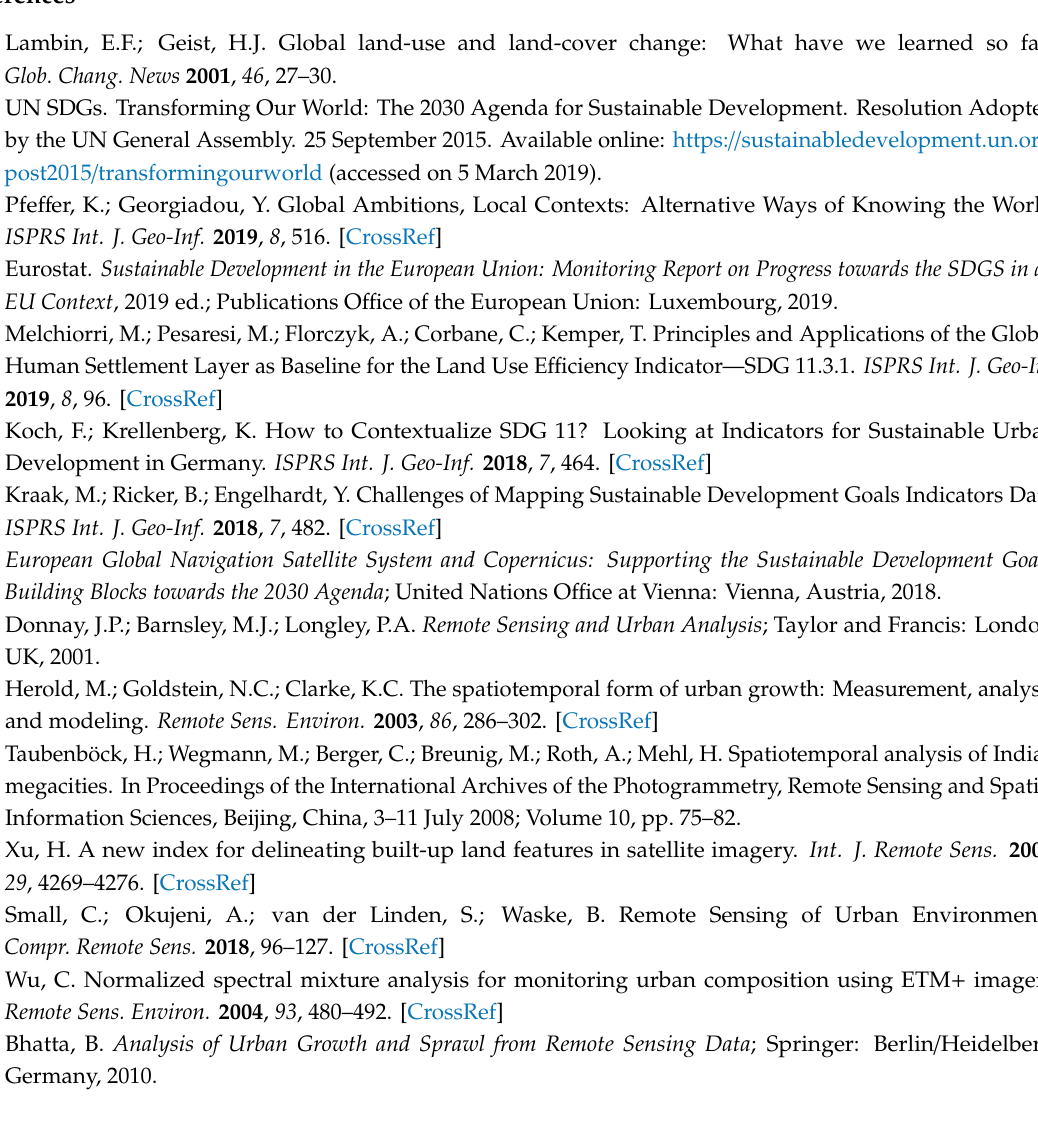
Table S1: Statistical analysis of ROIs areal extent, Figure S1: ROIs validation with high-resolution satellite imageries, Table S2: CORINE land cover nomenclature, Figure S2: CORINE land cover legend related to Figure